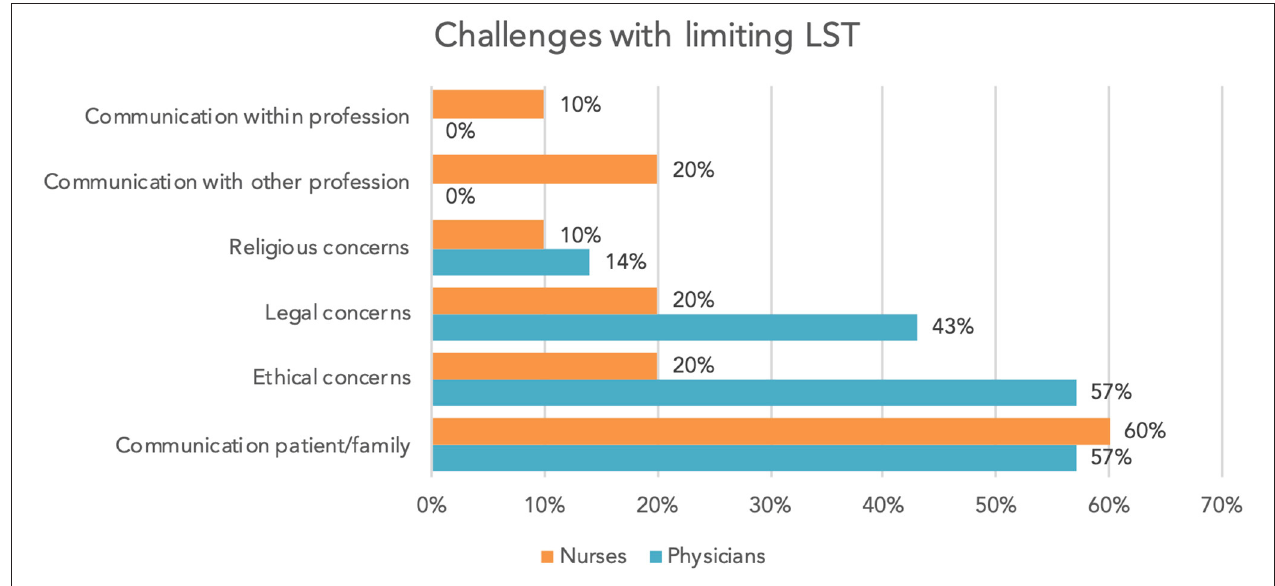
FIGURE 5 | Challenges for team with limiting